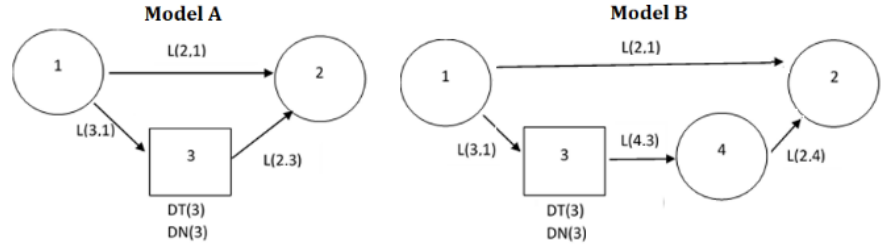
Figure 1. Permeation profiles of domperidone using 1% OA (oleic acid) in PG (propylene glycol) for pH 5 (n=3) and different concentrations of OA in PG for pH 1 (n=4).